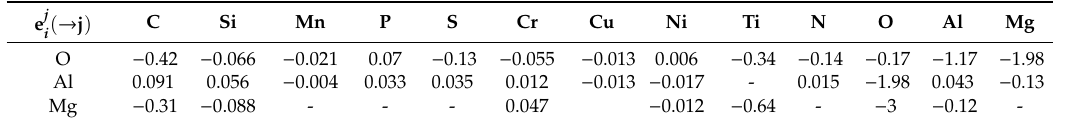
Table 6. Interaction coe ffi cients of O, Al, and Mg at 1873 K (1600 ◦ C).